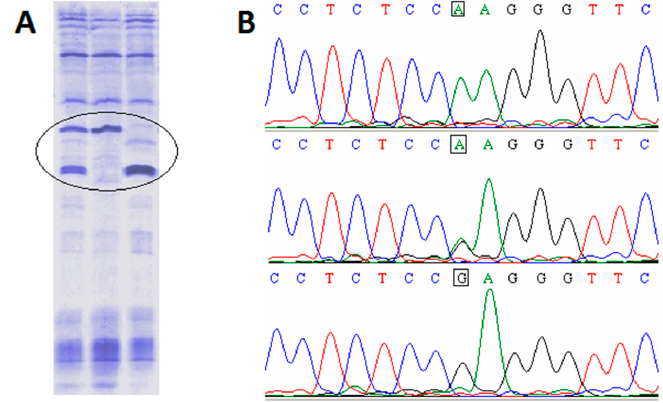
Figure 1. Porcine CSN2 c.647G>A polymorphism: ( A ) The isoelectric focusing (IEF) migrating profiles of the two polymorphic protein variants (lane 1—AG; lane 2—AA; lane 3—GG); ( B ) CSN2 cDNA sequencing chromatograms from 3 individuals carrying different genetic variants of the gene—the mutational event is marked with a